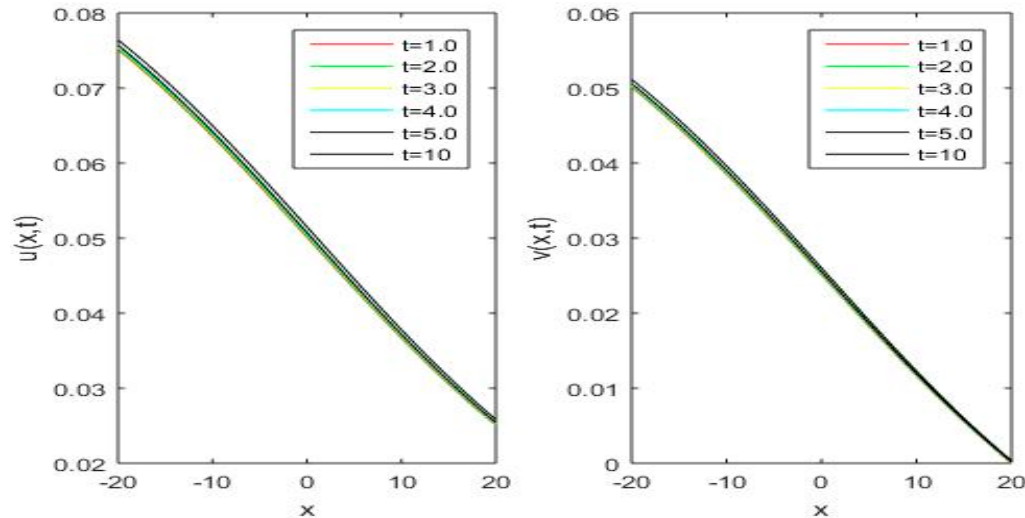
Figure 3. Comparison of absolute errors for different values of 𝑡 for Test Problem 1.